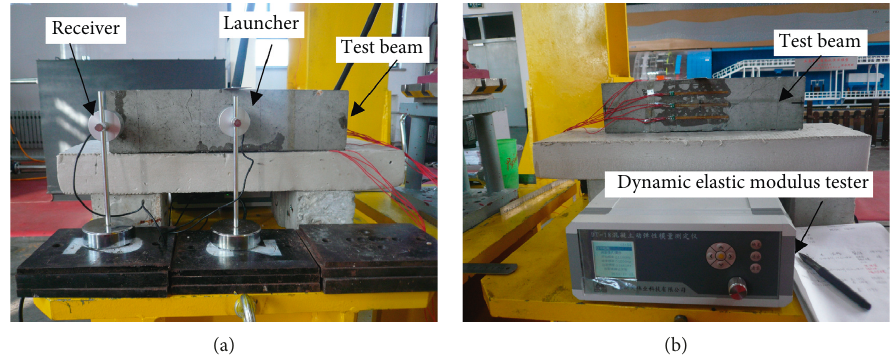
Figure 4: The dynamic elastic modulus measurement. (a) Front. (b)